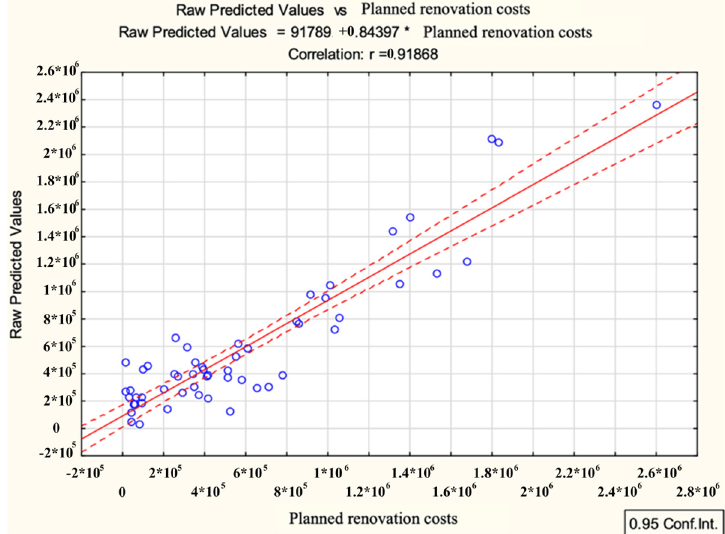
Figure 5. Predicted values and planned renovation costs.